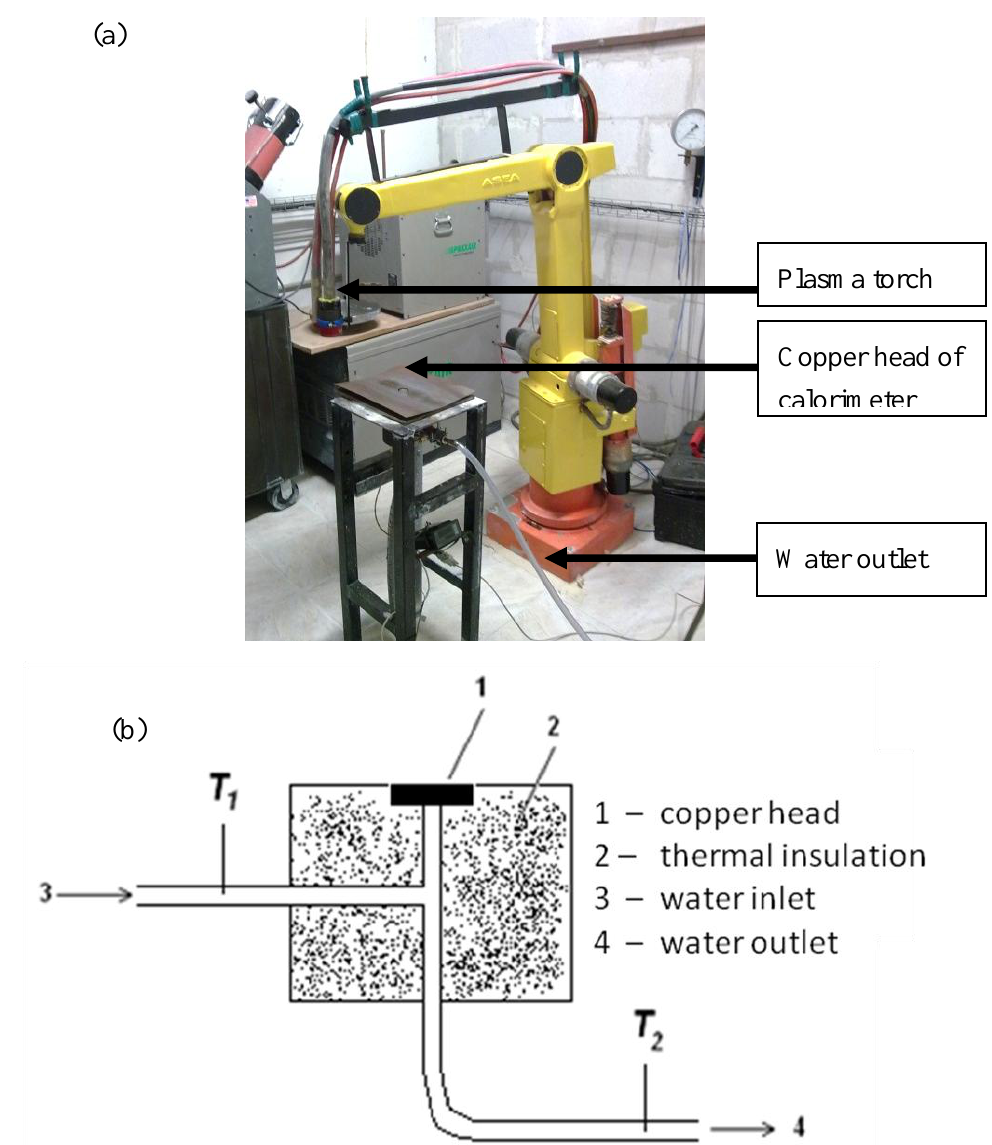
Figure 3. Experimental setup to determine the heat flux at suspension plasma spraying (a) a general overview (b) details of the calorimetric head.